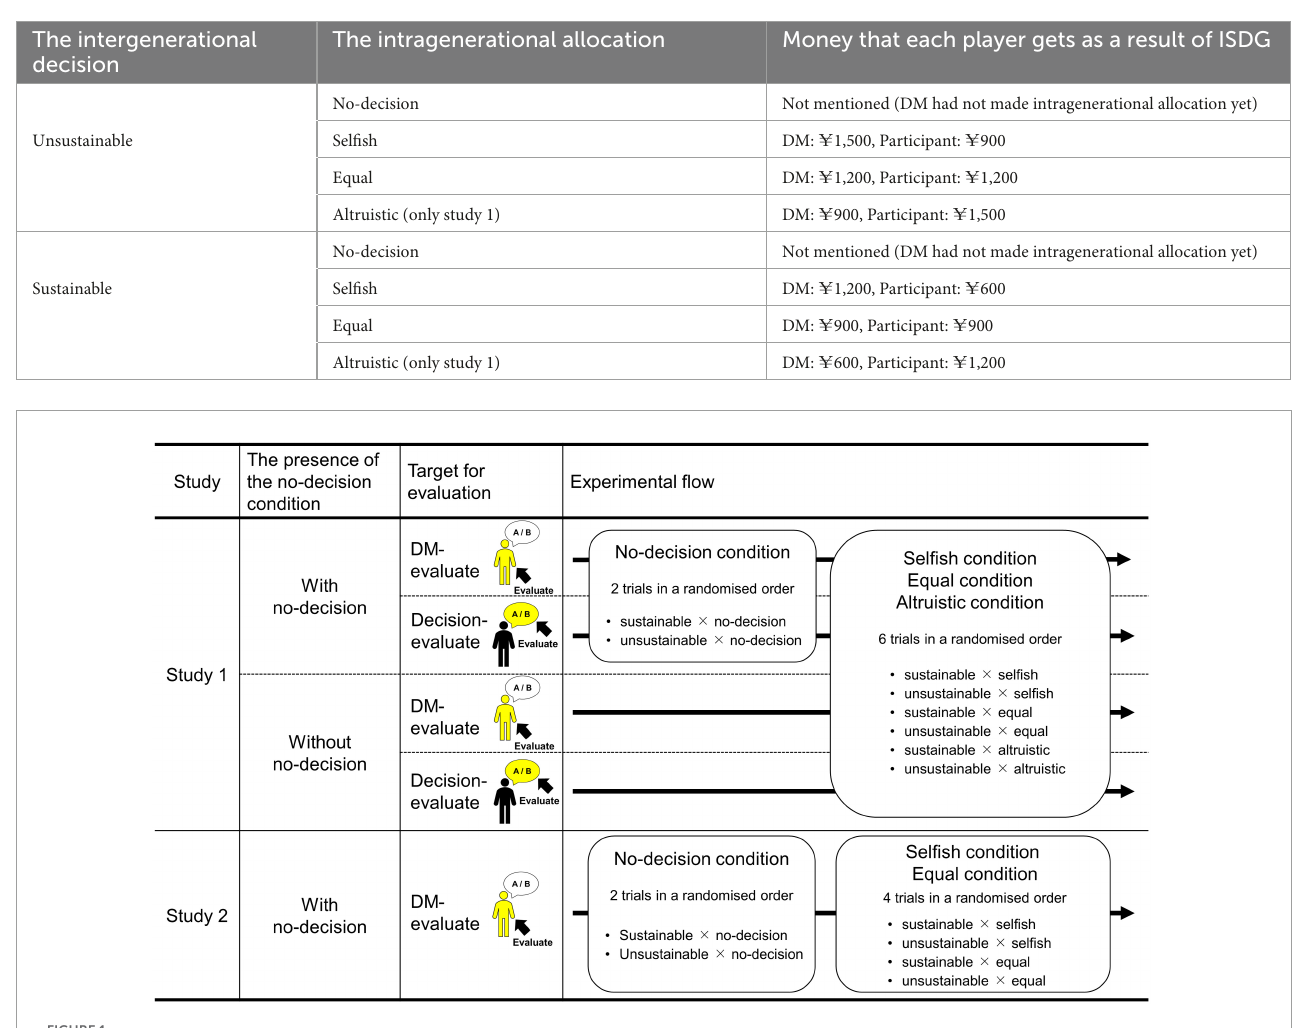
FIGURE1 The process of the ISDG evaluation task. The abbreviation “DM” means the decision maker.